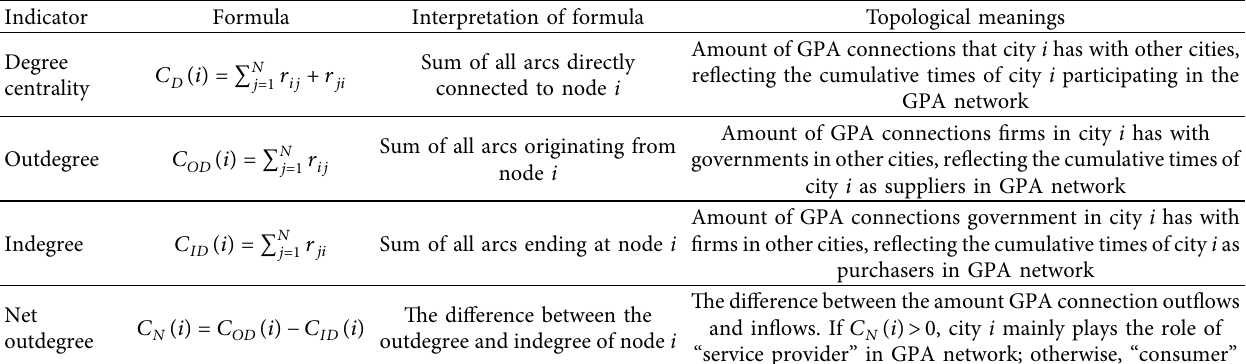
Table 3: Centrality metrics used to measure the importance of nodes in the GPA connection networks.